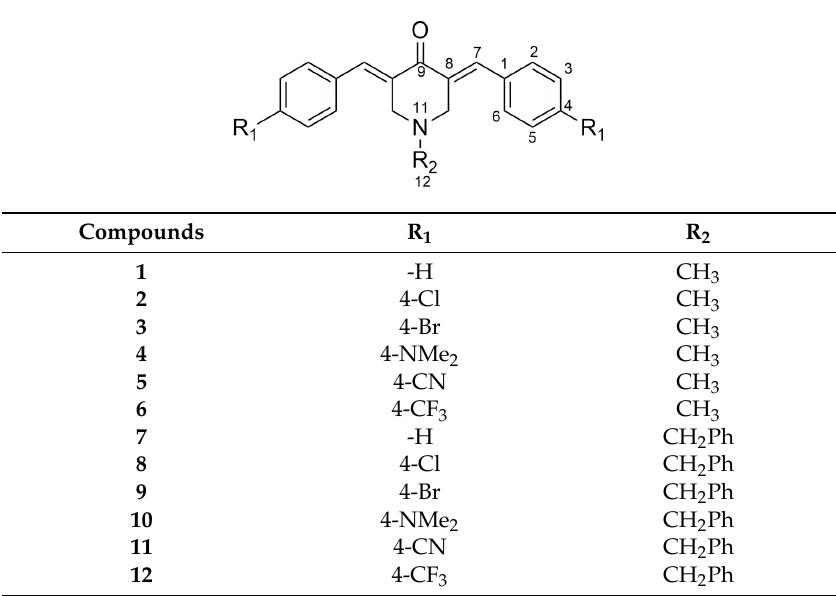
Table 1. Molecules studied in this work.